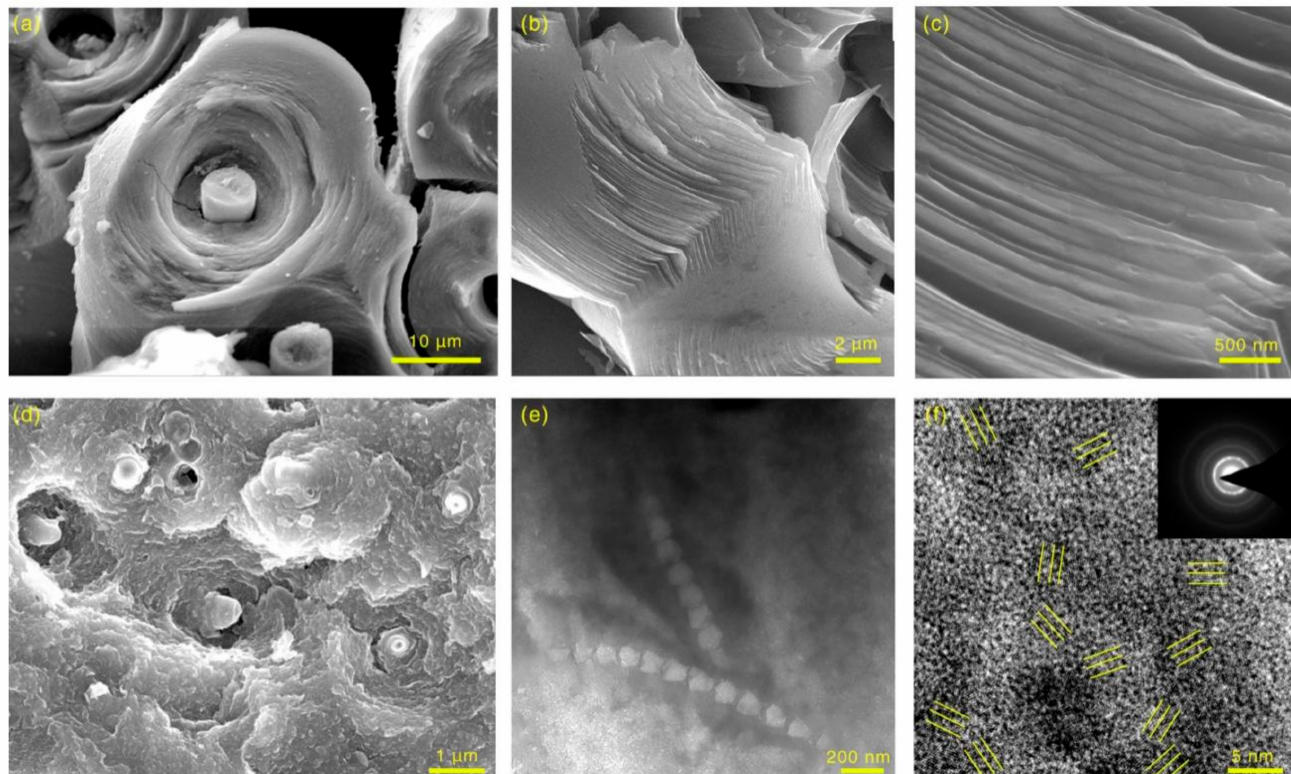
Figure 9. ( a – c ) Fracture morphology of C/C composites; ( d ) Fracture morphology of CC/C composites; ( e ) TEM image of the CNTs reinforced pyrocarbon matrix in CC/C composites; ( f ) HRTEM image of Pyrocarbon matrix in the CC/C composites (Insert f is the